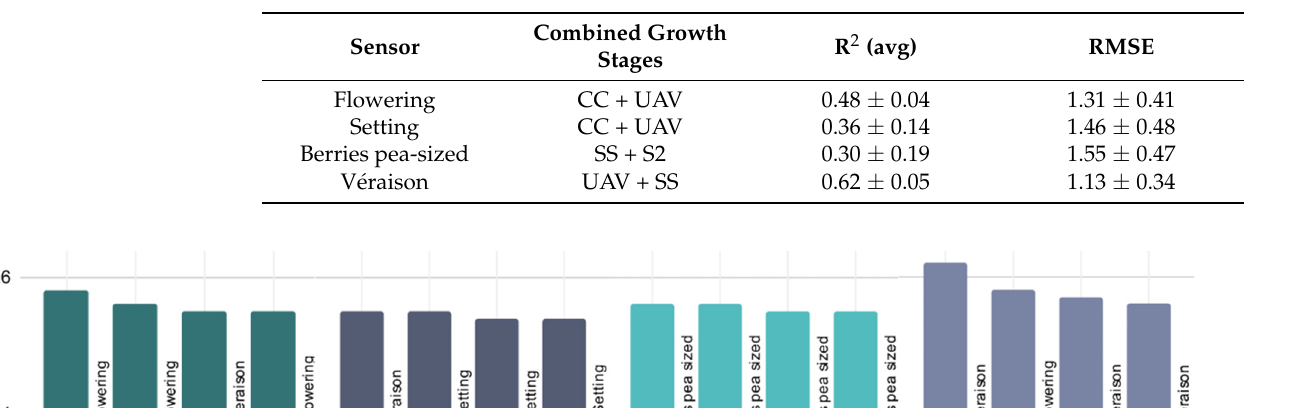
Table 7. Given a specific growth stage, the best combination of sensors and the corresponding best R2 over the two growing seasons (2019 and 2020), using AutoML to assess their performance in evaluating grape quality attributes (legend as for Table 2).